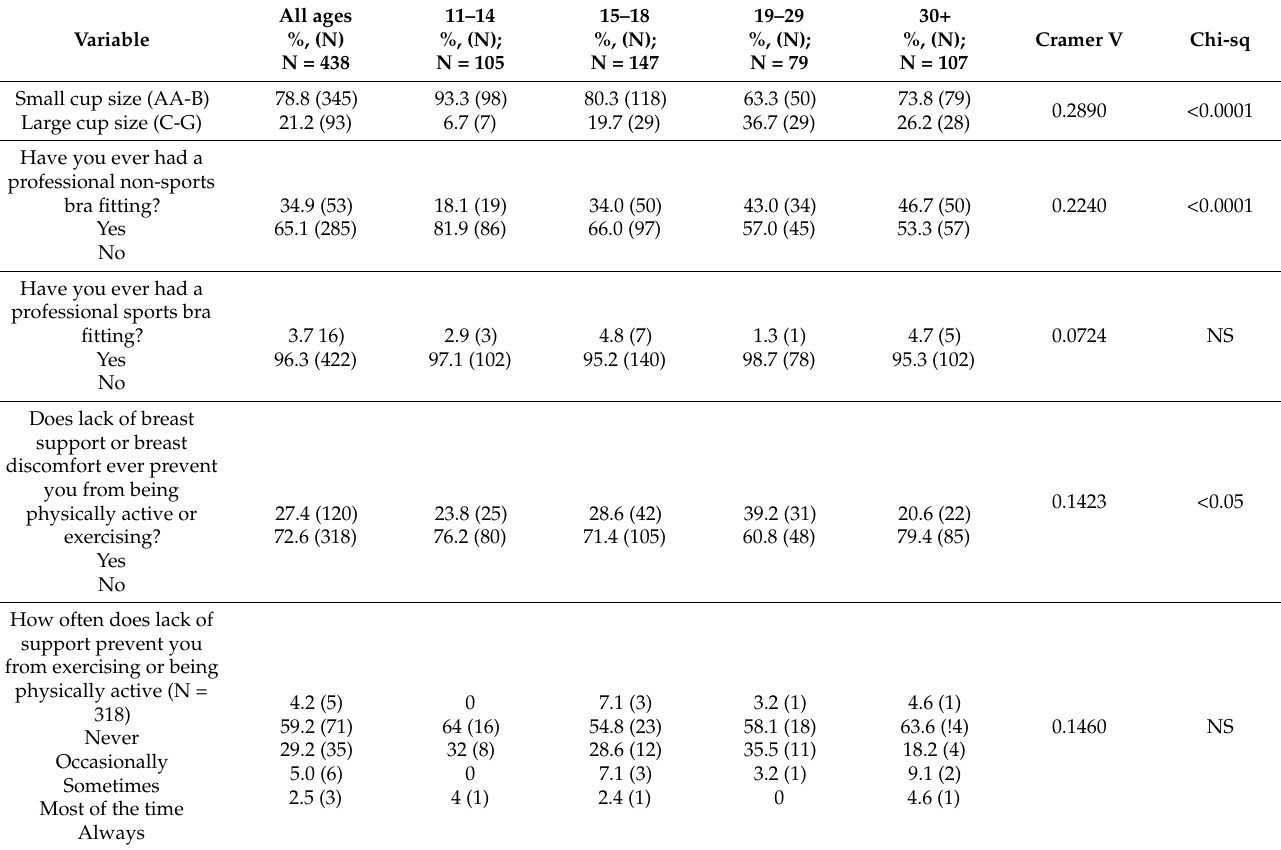
Table 2. Characteristics of the sport bras preferences of the sample